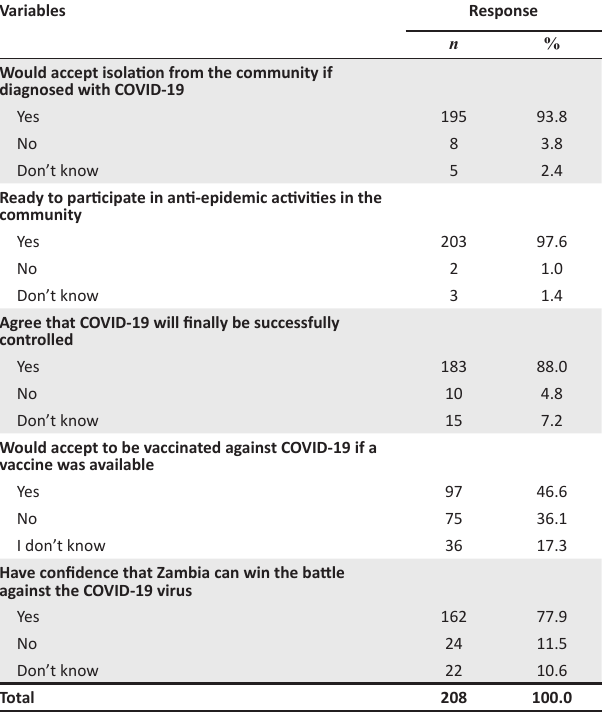
TABLE 6 : Attitude of biomedical professionals towards coronavirus disease 2019, Zambia, June 2020. Variables